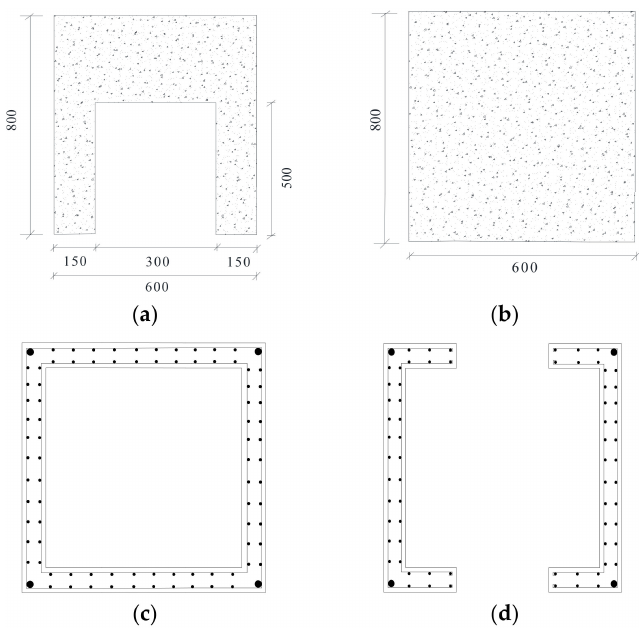
Figure 2. Details of core tube: ( a ) the south and north shear wall, ( b ) the west and east shear wall, ( c ) the reinforcement in the shear wall and ( d ) the reinforcement in the opening. (units: mm).